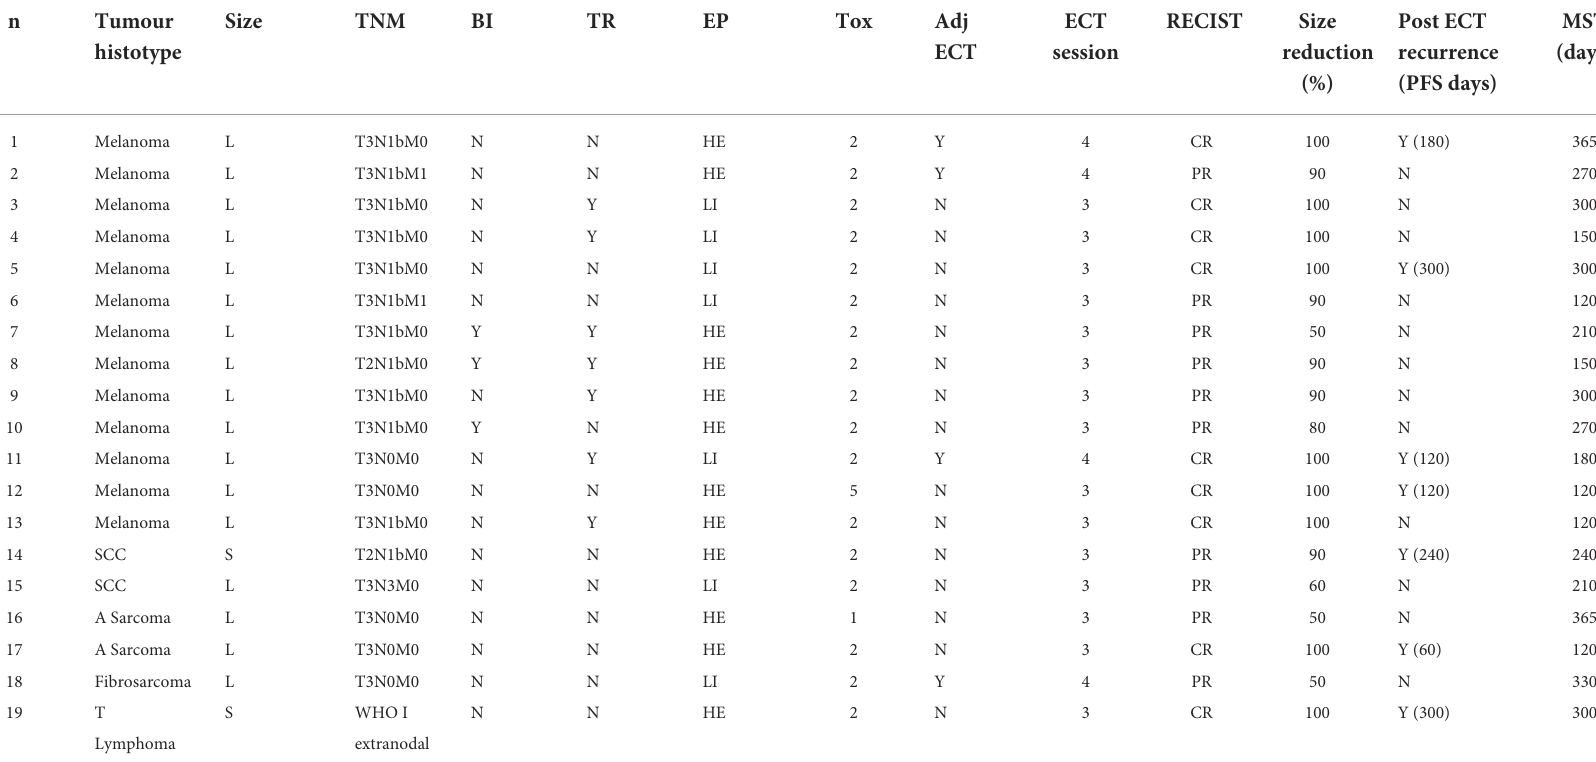
TABLE 1 Patient data for tumour histotype, tumour size, TNM staging system, tumour bone involvement (BI), tumour recurrences treated (TR), electrical parameters (EP), ECT toxicity grade (Tox), adjunctive ECT session (Adj ECT), total number of ECT session, RECIST evaluation criteria obtained after the ECT treatment protocol at 1 month follow up, tumour size reduction rate (%), tumour recurrence after electroporation and median survival time